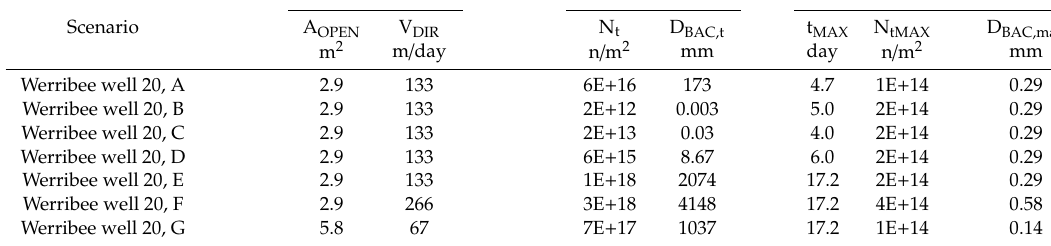
Werribee well 20, A 2.9